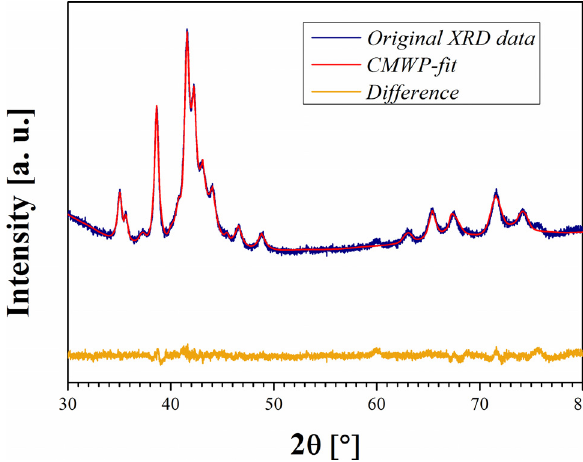
Figure 5: XRD pattern of the sample in the N=0 state with the CMWP fit. The difference between the measured data and the CMWP fit is also indicated.